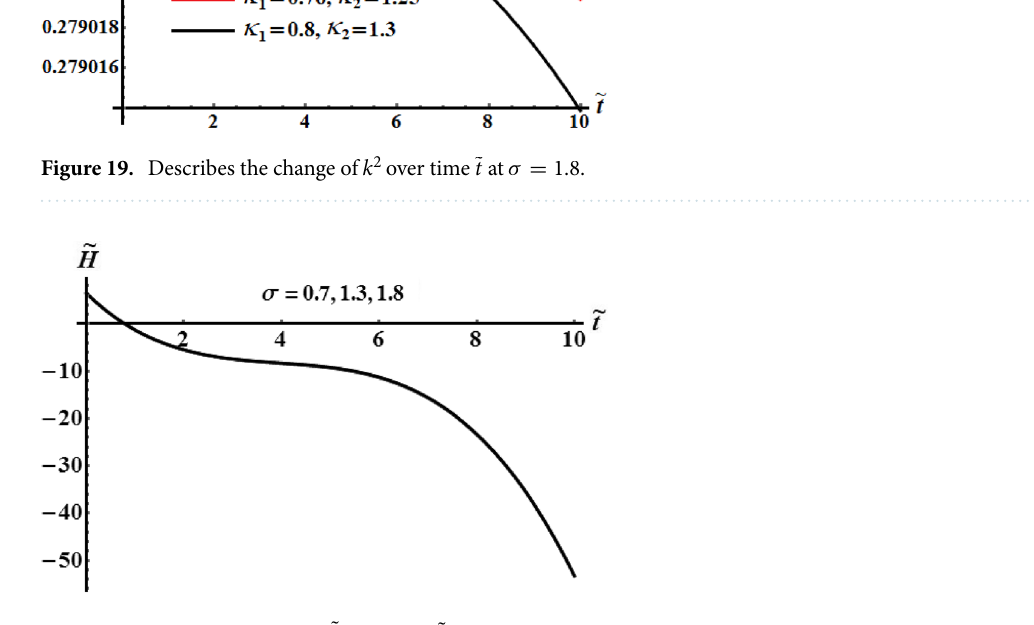
Figure 20. Shows the evolve of ˜ H over time ˜ t at σ ( = 0.7, 1.3, 1.8 ) .